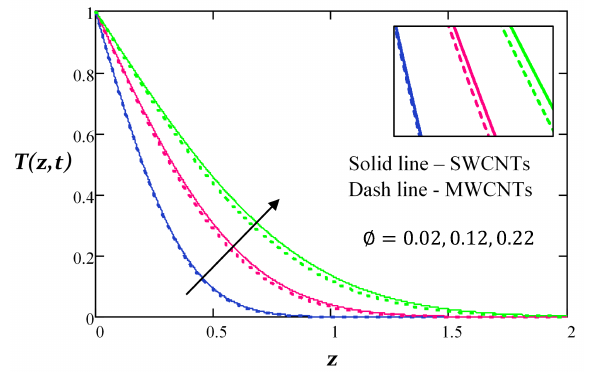
Fig. 4. Temperature profile under the impact of different t